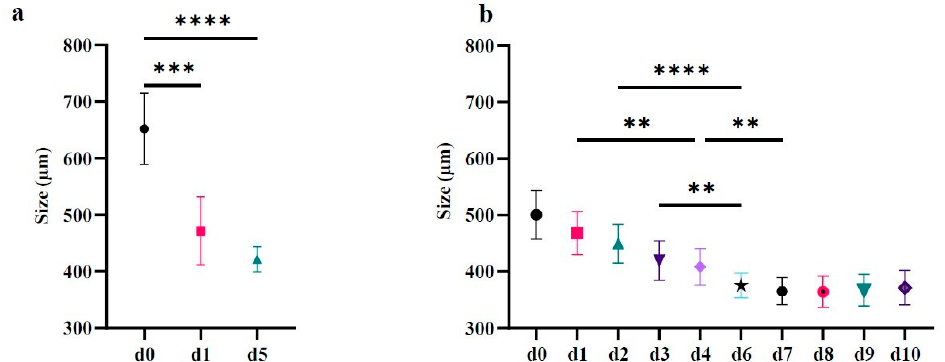
Figure 3. Size trend over days of CABA I spheroids. ( a ) Mean ± SD of 14 spheroids observed on d0, d1 and d5. ( b ) Mean ± SD of 35 spheroids observed on d0-d10. Kruskal–Wallis test followed by Dunn’s post-hoc test (** p < 0.01; ***: p < 0.005; **** p < 0.001). In each graph, asterisks on horizontal bars represents the statistical significance between the two values selected. In b, all values, starting from d3 are statistically significant compared to d0 (**** p < 0.001; only d3 ** p < 0.01). Table 1. Minimum, maximum and mean size of 34 spheroids population for each